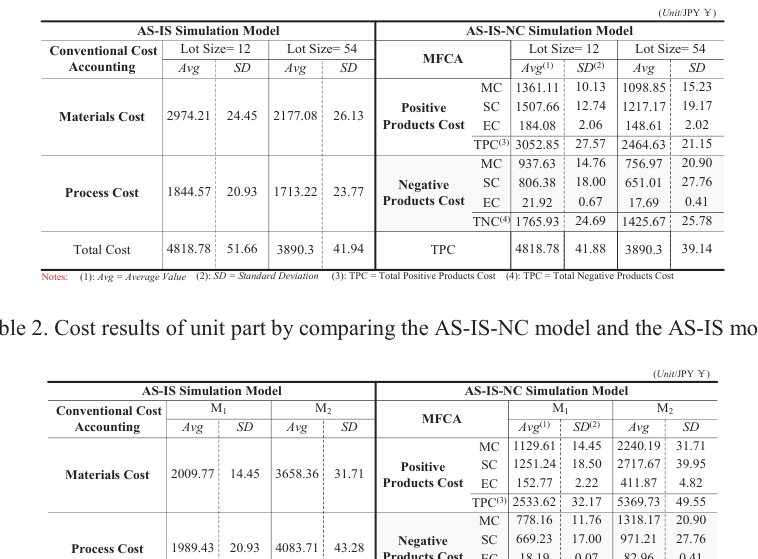
Table 1. M 2 Cost results of unit part by comparing the AS-IS-NC model and the AS-IS model.